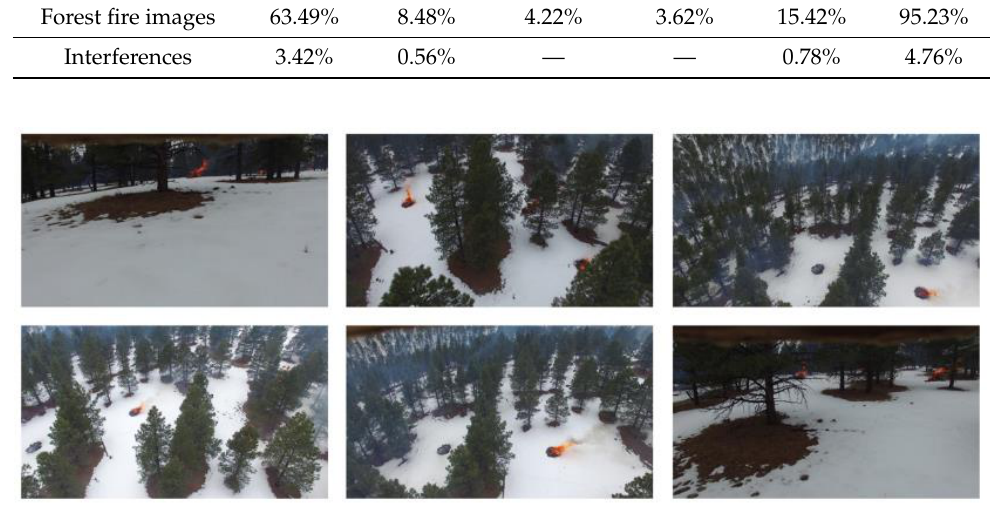
Table 1. Distribution and proportion of dataset.